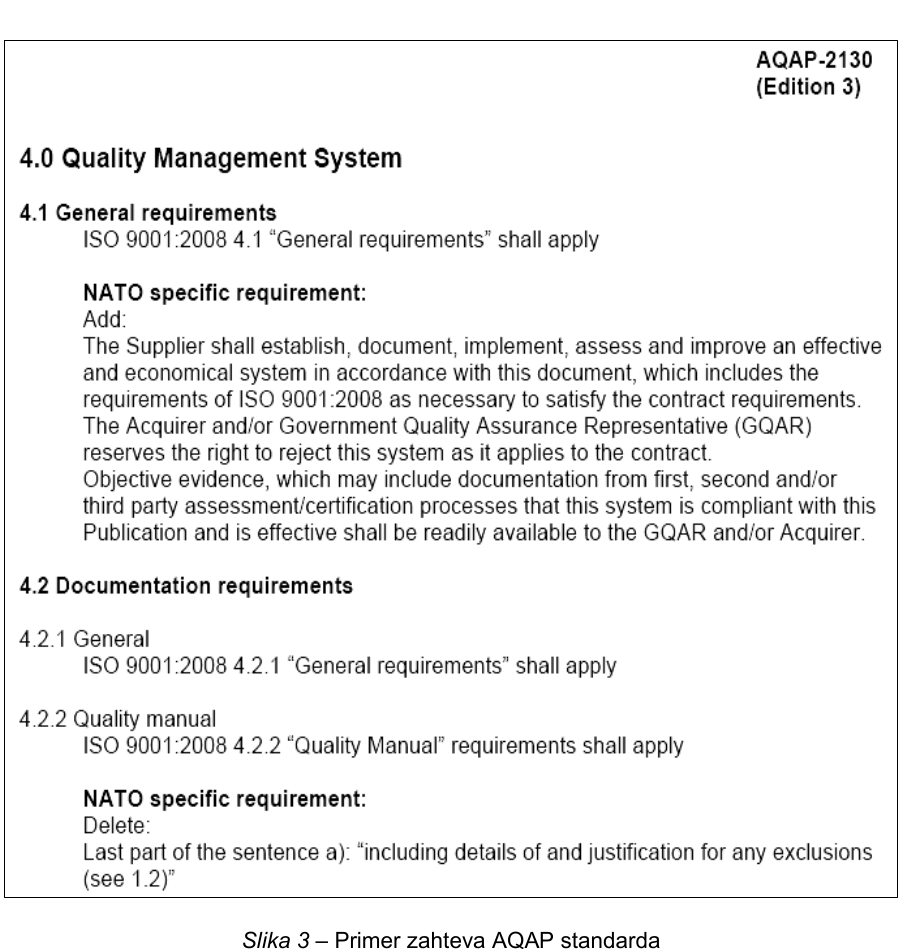
Figure 3 – Example of a request of the AQAP